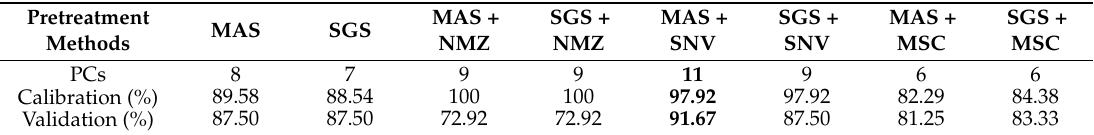
Table 1. Comparison of classification models with different pretreatment methods based on kernel samples orientated with germ up.